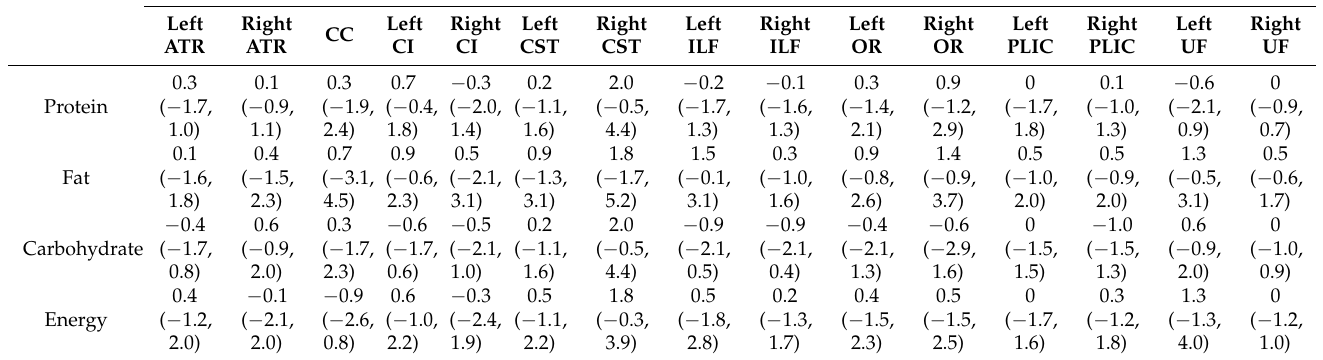
Table 4. Associations of macronutrient intake with fractional anisotropy of white matter tracts at term equivalent age ( n =